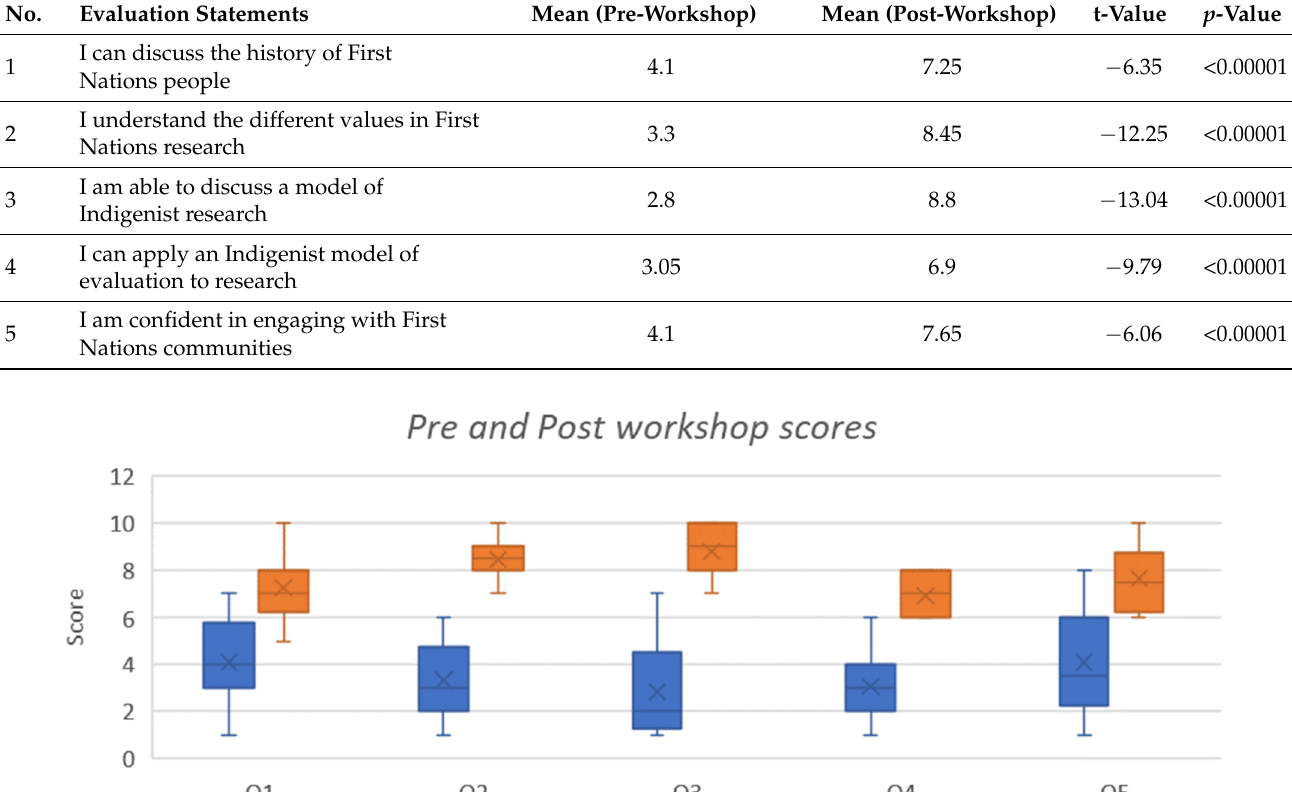
Table 3. Pre- and Post-Workshop Evaluation Results.